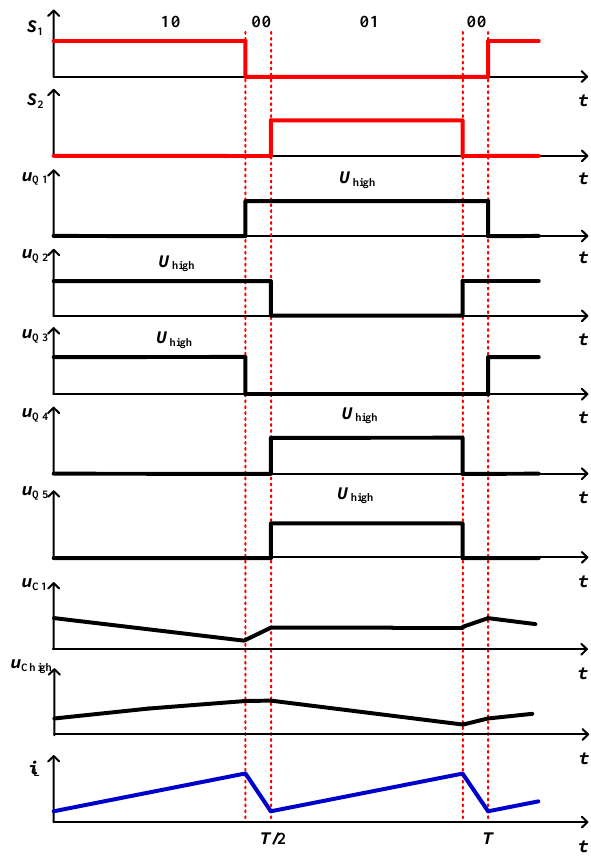
Figure 4. Typical waveforms of the proposed converter in the step-up mode.